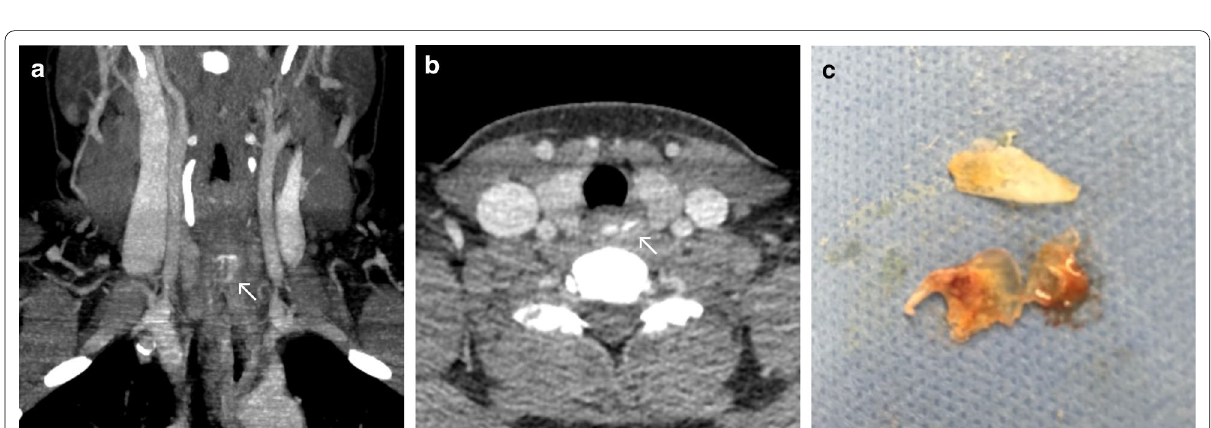
Fig. 16 Fish scales. Coronal maximum intensity projection ( a ) and axial CT image ( b ) showing a flat hyperdense structure in the upper oesophageal sphincter. Photograph of multiple fish scales after endoscopic removal from the proximal oesophagus ( c